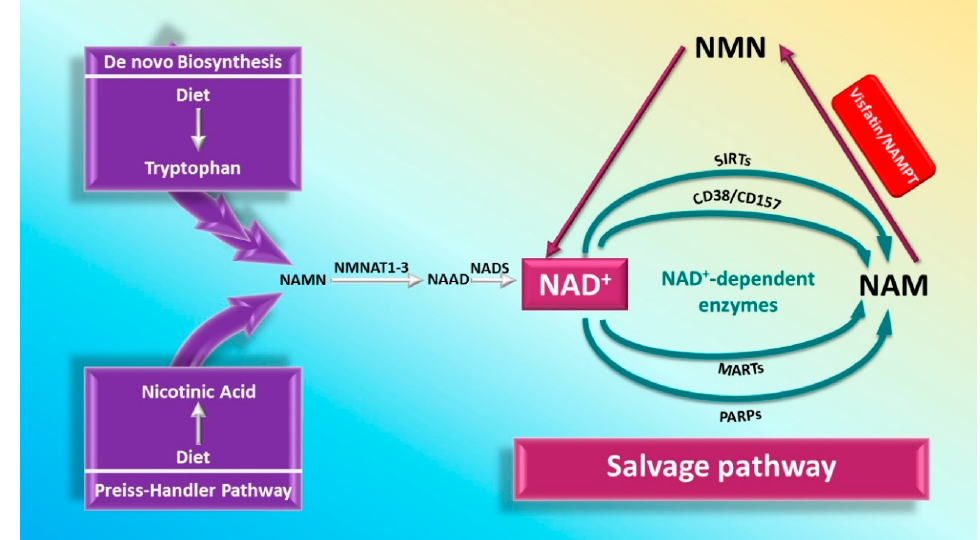
Figure 1. The three-mammalian nicotinamide adenine dinucleotide (NAD + ) biosynthesis pathways.